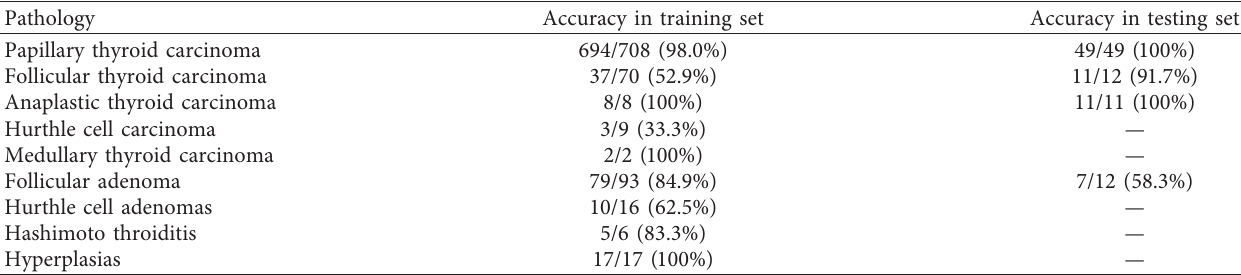
Table 4: The accuracy of the IRC in various pathological classification.